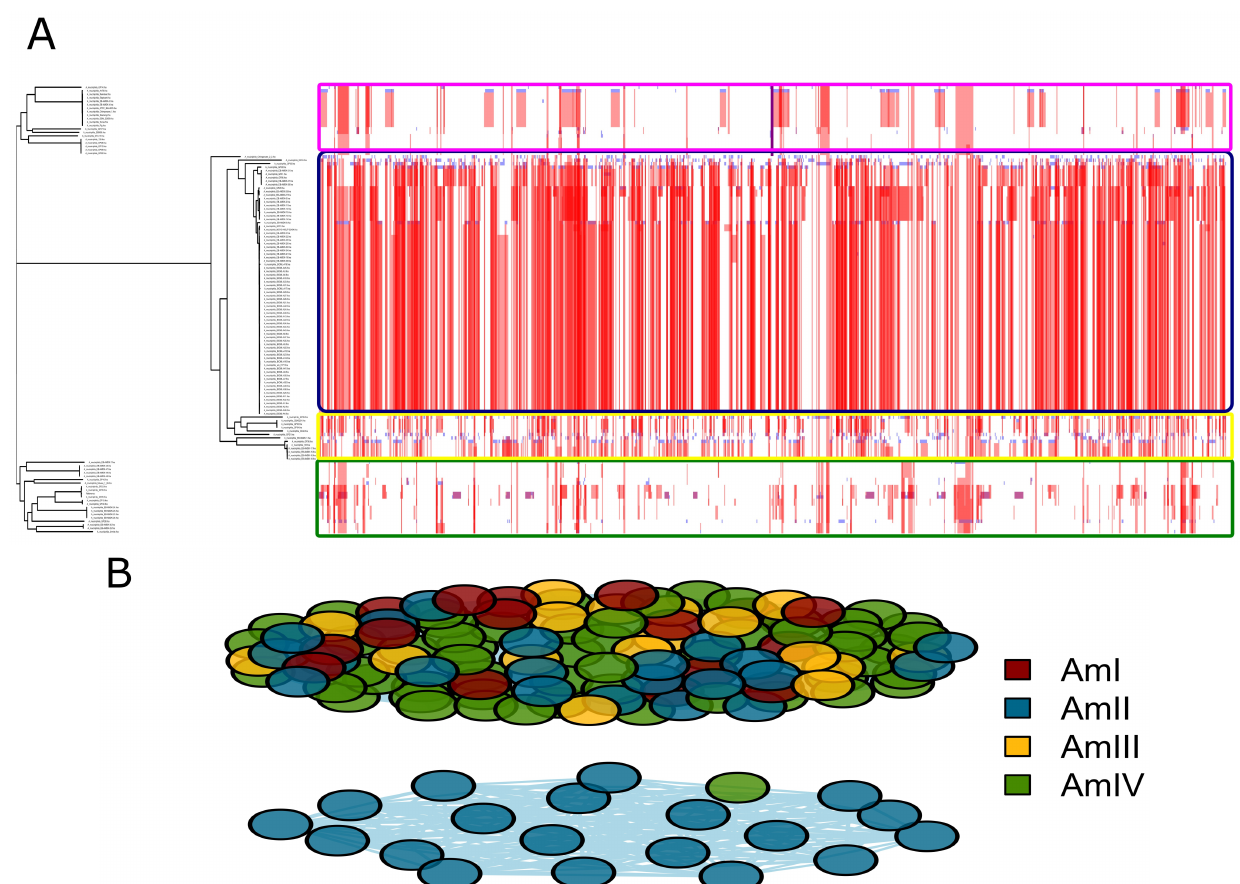
Figure 9. Evolutionary dynamics of A. muciniphila depicting recombination. ( A ) Recombination among different strains as depicted by Gubbins. Based on the recombination pattern, it is evident that all phylogroups share recombination as indicated by the red tiles. ( B ) Network graph of the recombination pattern showed two distinct clusters. One cluster contains strains from all